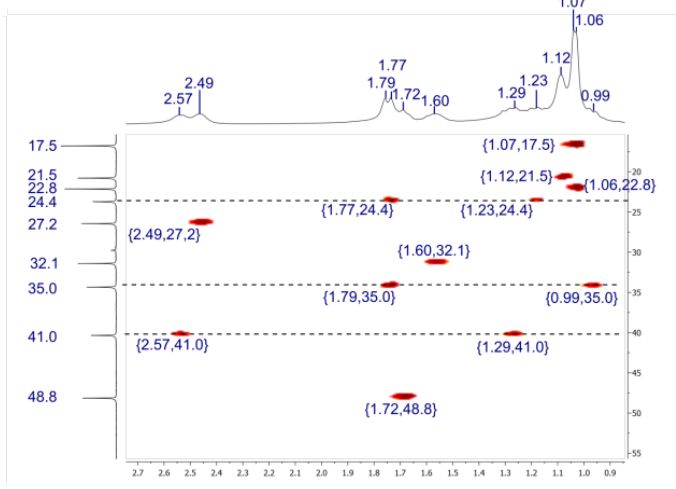
Figure 2. Fragment of 1 H– 13 C HSQC NMR spectrum of 2 in pyridine- d 5 .